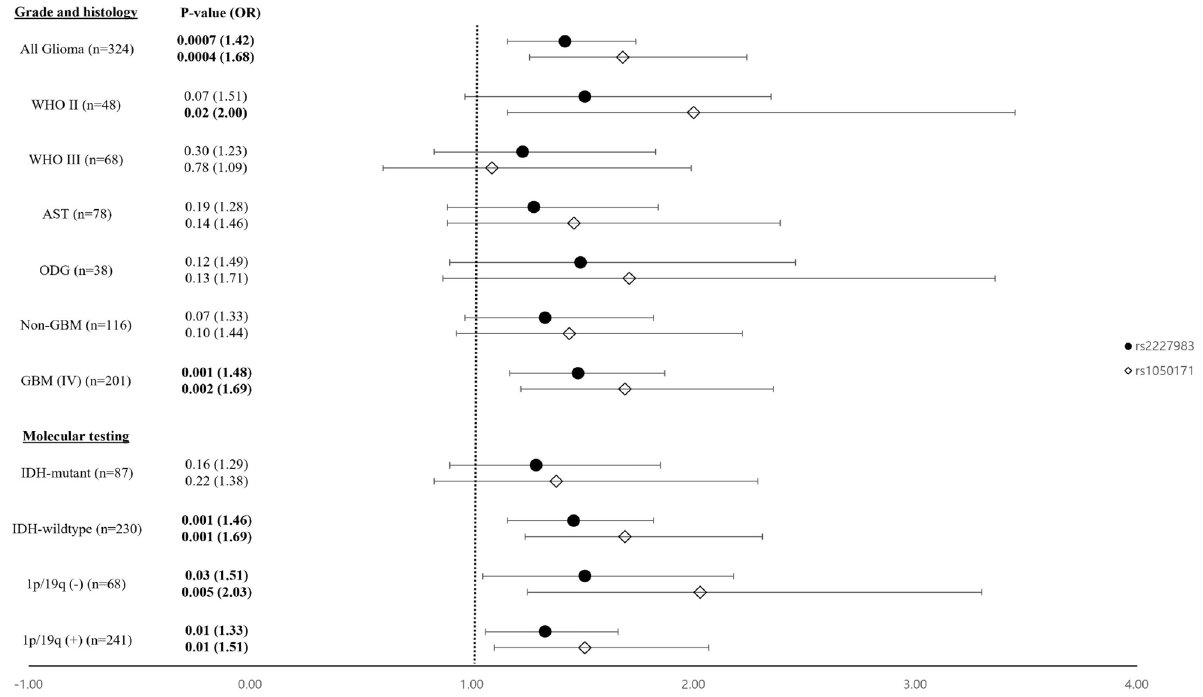
Figure 2. The association result of two independent SNPs between glioma subgroups and PCs. Logistic regression between glioma subgroups and PCs (n = 480) under additive model, adjusted by age and sex as covariates, was used for calculating ORs (95% CI) and P-values at rs2227983 and rs1050171. Each plot indicates the point estimate of ORs on the X-axis shown with 95% CI on the error bars. Significant associations are bolded. PC population control, WHO world health organization, AST astrocytomas, ODG oligodendrogliomas, GBM glioblastomas, IDH-mutant IDH1 or IDH2-mutated gliomas, IDH-wildtype IDH-wildtype gliomas, 1p/19q (-) 1p/19q codeletion, 1p/19q ( +) 1p/19q non-codeletion, OR odds ratio, PCs population control, CI confidence